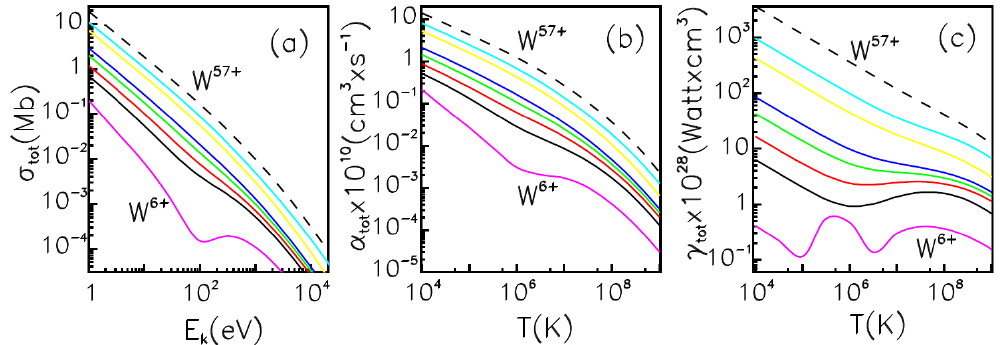
Figure 3. Total RRCS ( a ), RR rates ( b ) and RPL rates ( c ) for representative tungsten ions. Rose, W 6+ ; black solid, W 14+ ; red, W 17+ ; green, W 20+ ; blue, W 23+ ; yellow, W 35+ ; light blue, W 45+ ; black dashed W 57+